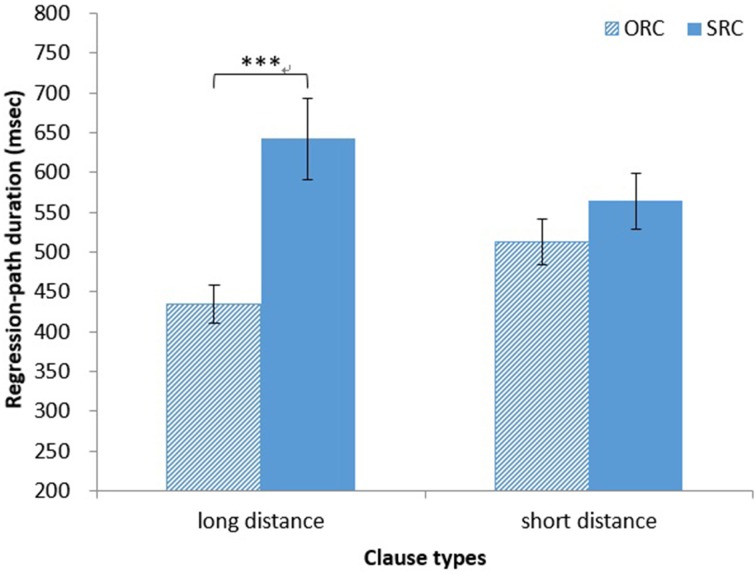
Japanese group: regression-path durations for HNs in RCs. ***p < 0.001.